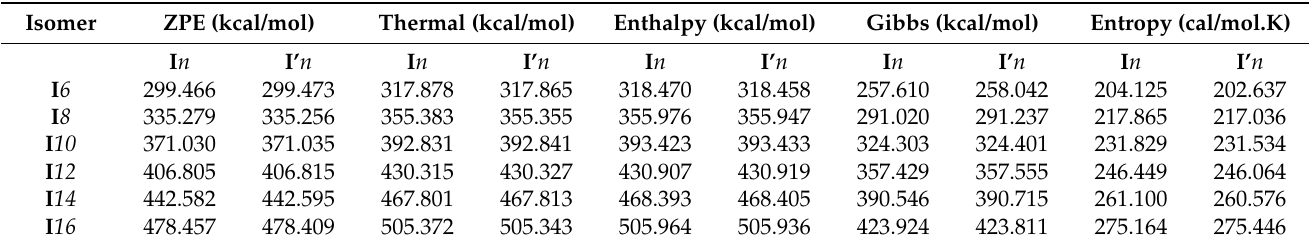
Table 4. Zero-point energy and thermodynamic parameters for series I n , calculated at B3LYP/6-